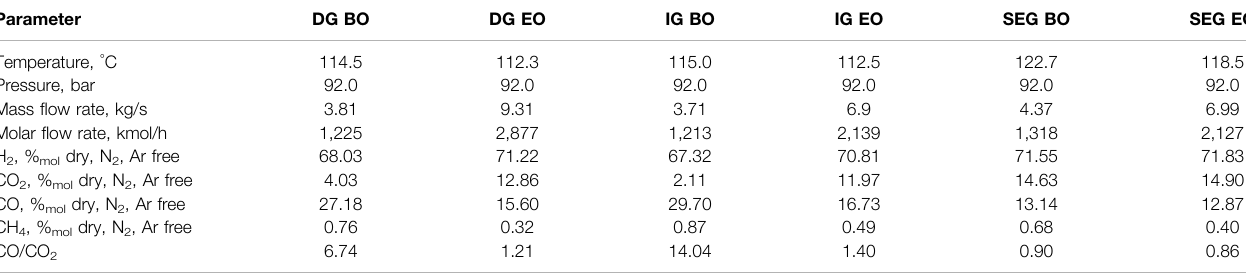
TABLE 3 | Syngas speci fi cations upstream of the methanol synthesis island in baseline and enhanced operating conditions. Parameter DG BO DG EO IG BO IG EO SEG BO SEG EO Temperature, °